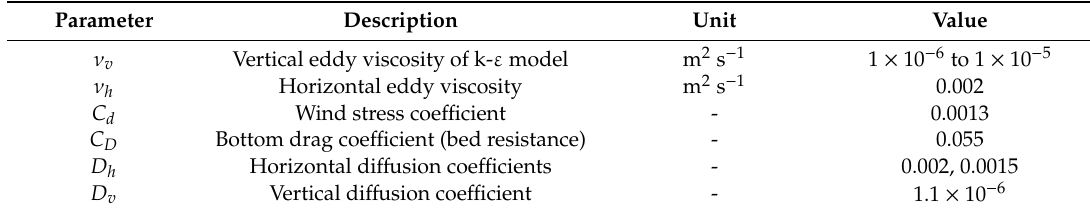
Table 2. Parameters used in the MIKE3